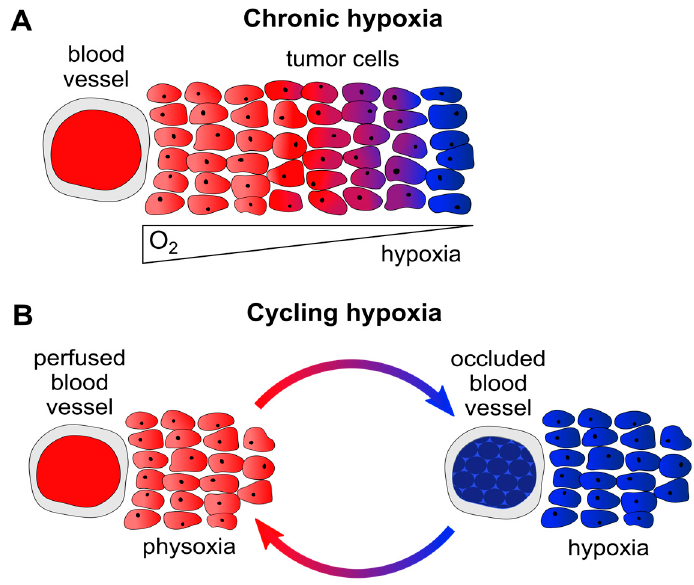
Figure 1. Chronic and cycling hypoxia. ( A ) Diffusion-limited chronic hypoxia due to enlarged distances between tumor blood vessels and tumor cells. Remote tumor cells (>70 µm away from the blood vessel [1]) are inadequately supplied with O 2 and become hypoxic. Red: oyxgenated tumor cells, blue: hypoxic tumor cells; ( B ) Perfusion-limited cycling hypoxia. Tumor vessels are often abnormally structured and can be temporarily occluded, e.g., through blood cell aggregates. Surrounding tumor cells will be exposed to fluctuating cycles of physoxia (left) or hypoxia (right). Red: oyxgenated tumor cells, blue: hypoxic tumor cells.